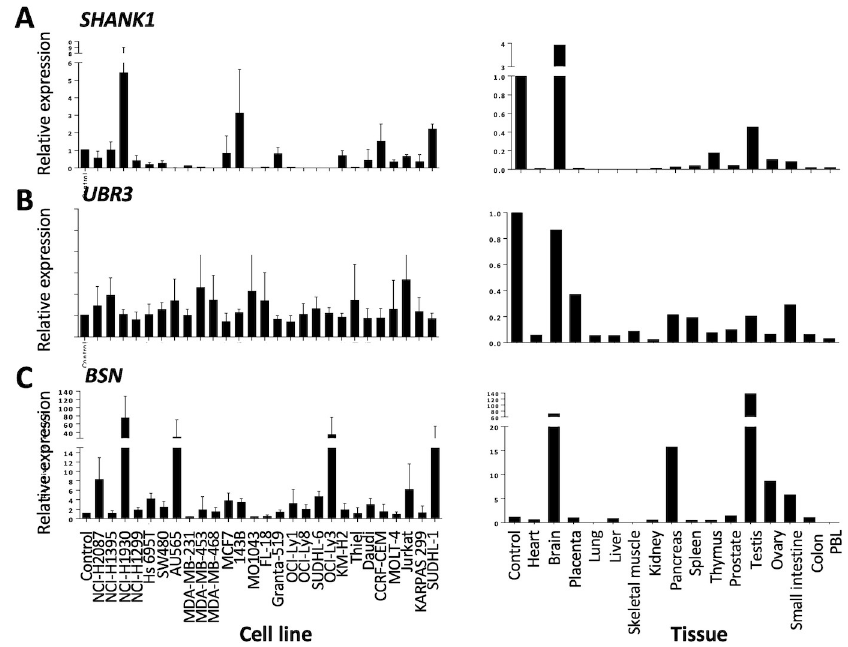
Fig 2. Transcript expression of genes encoding T1-116C cross-reactive peptides in cancer cell lines and in normal human tissues. Quantitative real time PCR (qPCR) analysis of transcript expression for (A) SHANK1 , (B) UBR3 and (C) BSN in cancer cell lines (left) and in normal human tissues (right). For the qPCR analysis of transcript expression in cancer cell lines, transcript expression was determined using a Taqman probe that corresponds to the cross-reactive peptides. Expression was normalized to TBP, 18S RNA and HPRT1 and expressed relative to expression in control cancer cell lines (MDA-MB-453 for UBR3 and BSN , or ACH-N for SHANK1 ). The coding exon for the cross-reactive peptides is exon 5 (Ex5) for BSN , Ex22 for SHANK1 and UBR3 . For the cancer cell lines, combined data from three replicate experiments is presented, whereas for the normal human tissues the MTC TM Panels are composed of samples from at least five different tissues and the results of one representative experiment are presented. For the normal human tissues, Clontech’s Human MTC TM Panel I and II were used to analyse transcript expression using a Taqman probe corresponding to the exon encoding the cross-reactive peptide. Expression was normalized to GAPDH and B2M and expressed relative to a control cancer cell line (MDA-MB-453 for UBR3 and BSN , or ACH-N for SHANK1 ).